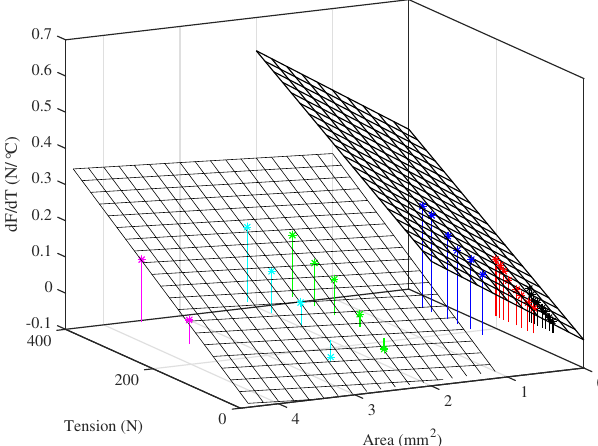
Figure 17. The thermal sensitivity dF / dT of the tension of the strings while held at constant length (with no tuning adjustments) plotted as a function of the string tension F 0 at the base temperature (20 ◦ C) and the unstretched cross-sectional area A N . Colours identify the di ff erent tested strings (Table 1): black (8:A6), red (14:A5), blue (5:A4), green (23a:A3), cyan (29:E3), magenta (10b:A2).